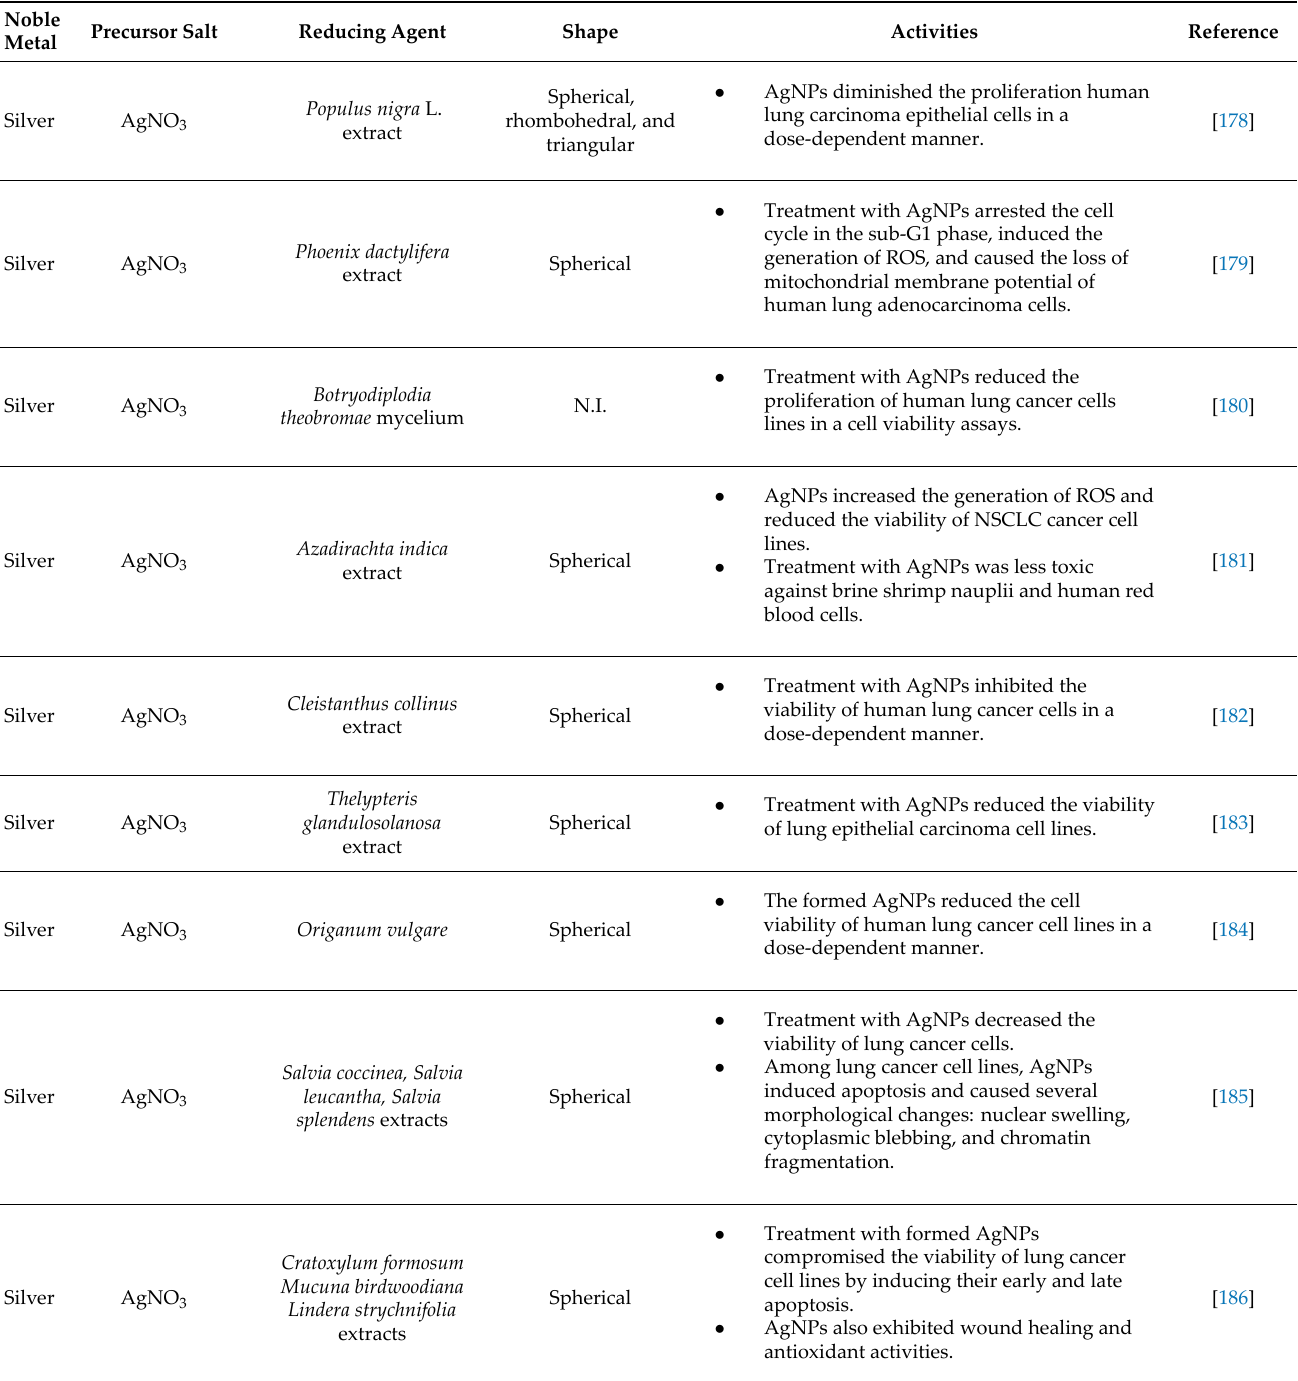
Table 3. Activities of biosynthesized AgNPs against